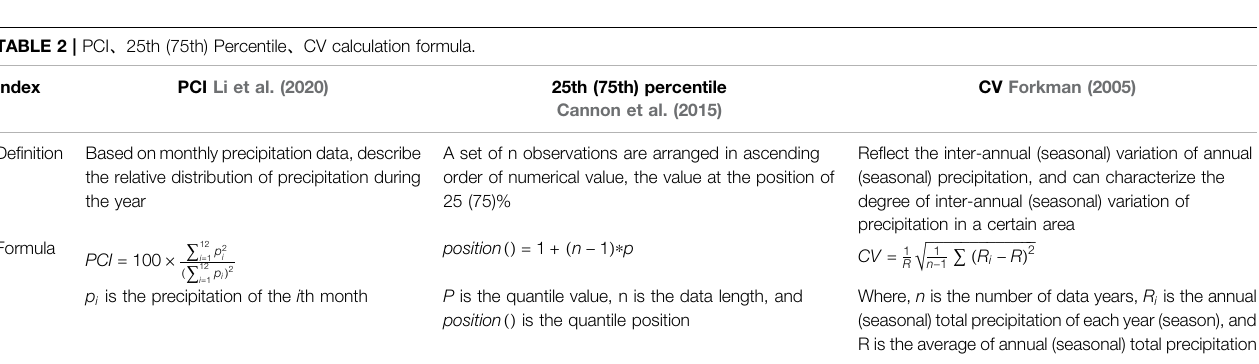
TABLE 2 | PCI 、 25th (75th) Percentile 、 CV calculation